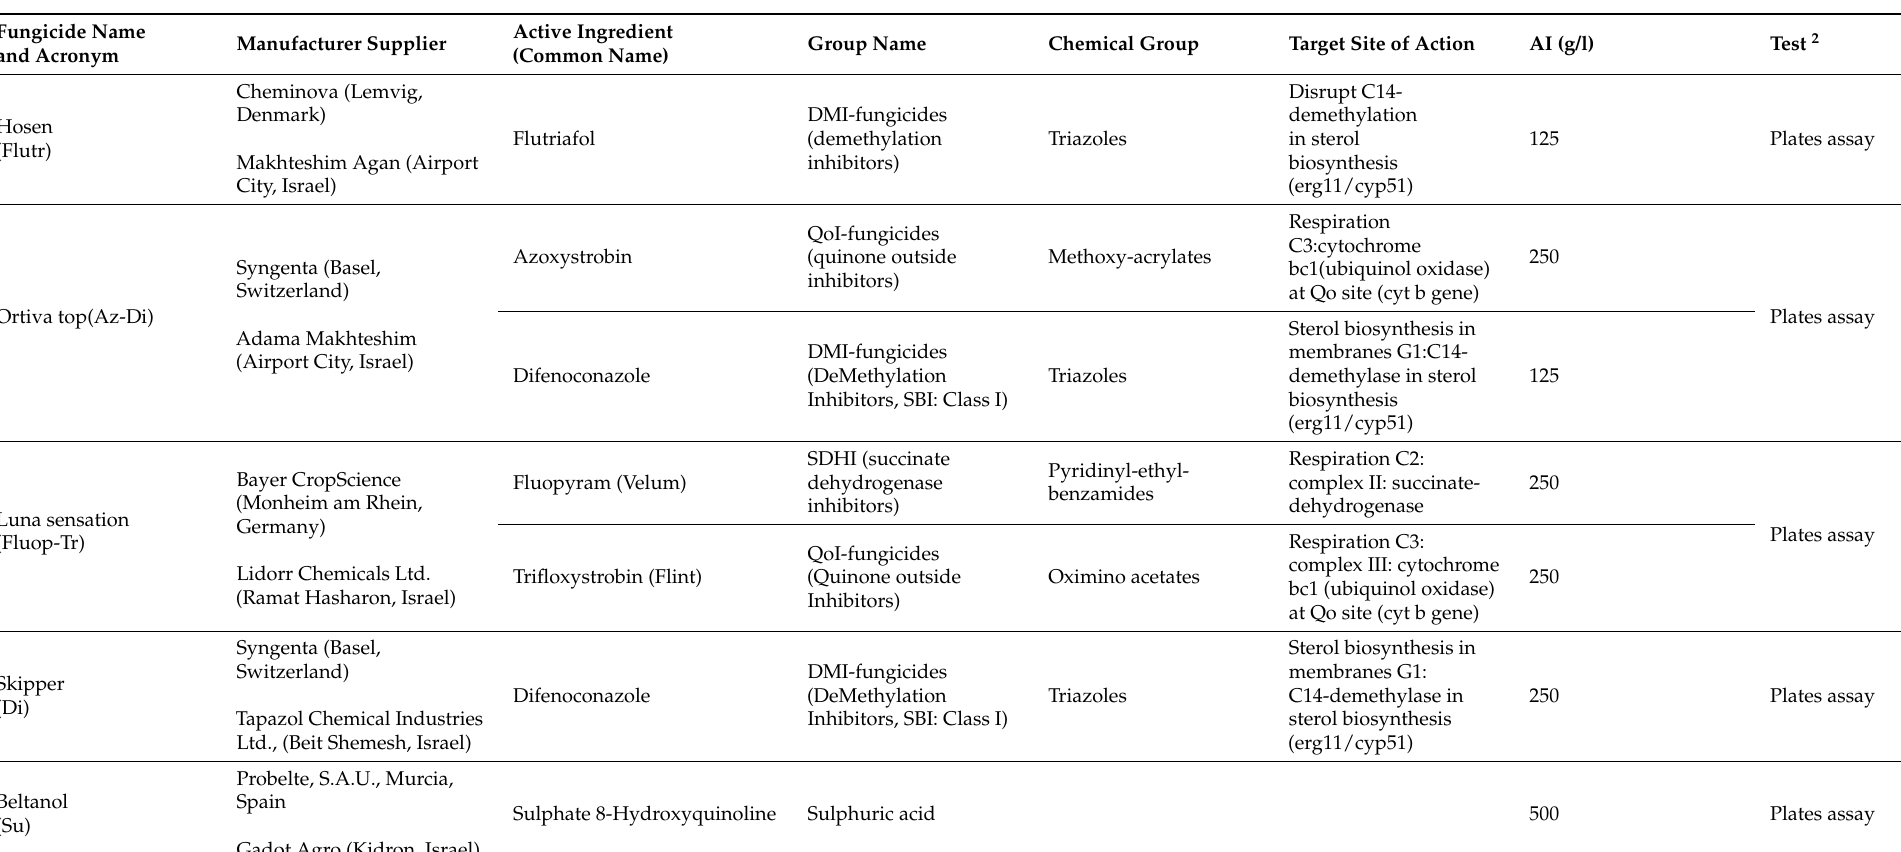
Table 1. Details of the preparations used in this study 1